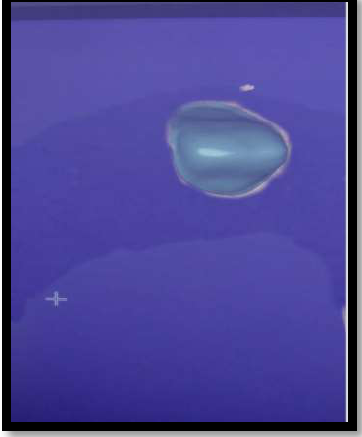
Figure 1. Fabrication of coping in CAD/CAM.